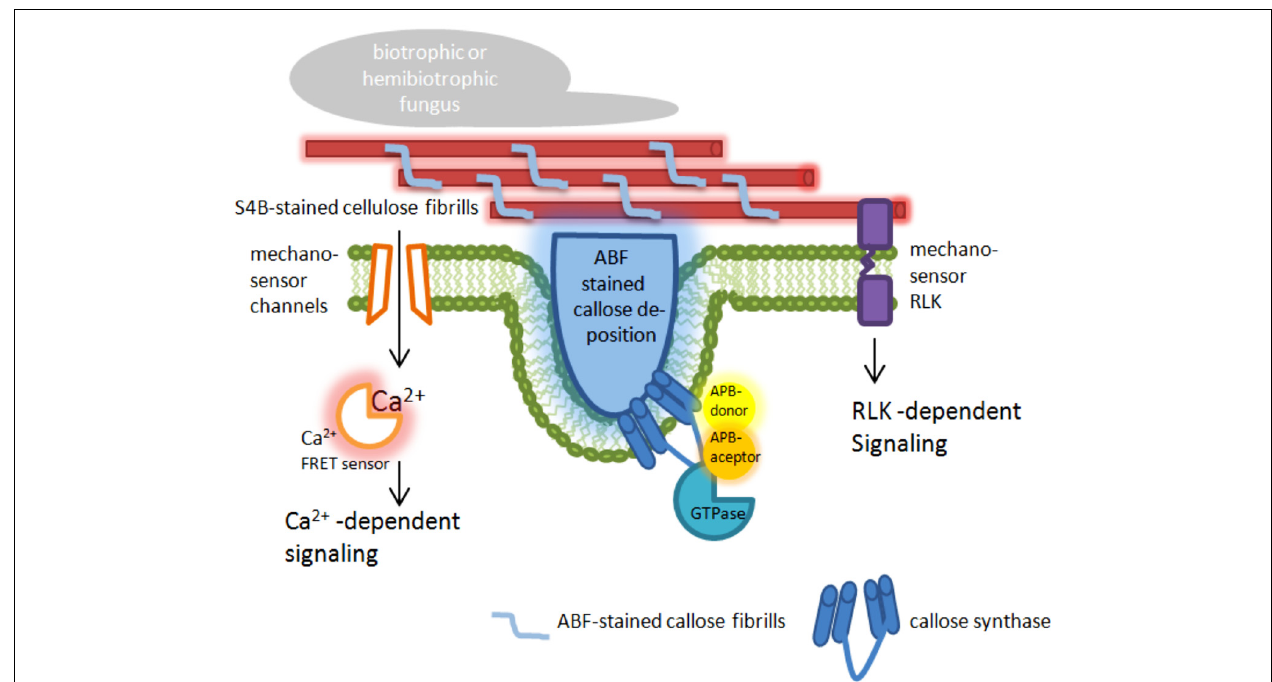
FIGURE 1 |Targets for nanoscale microcopy tools to analyze plant immunity-related cell wall modifications. The presented model highlights possible targets at the plasma membrane and the cell wall in epidermal leaf cells of plants attacked by pathogens. ABF, aniline blue fluorochrome